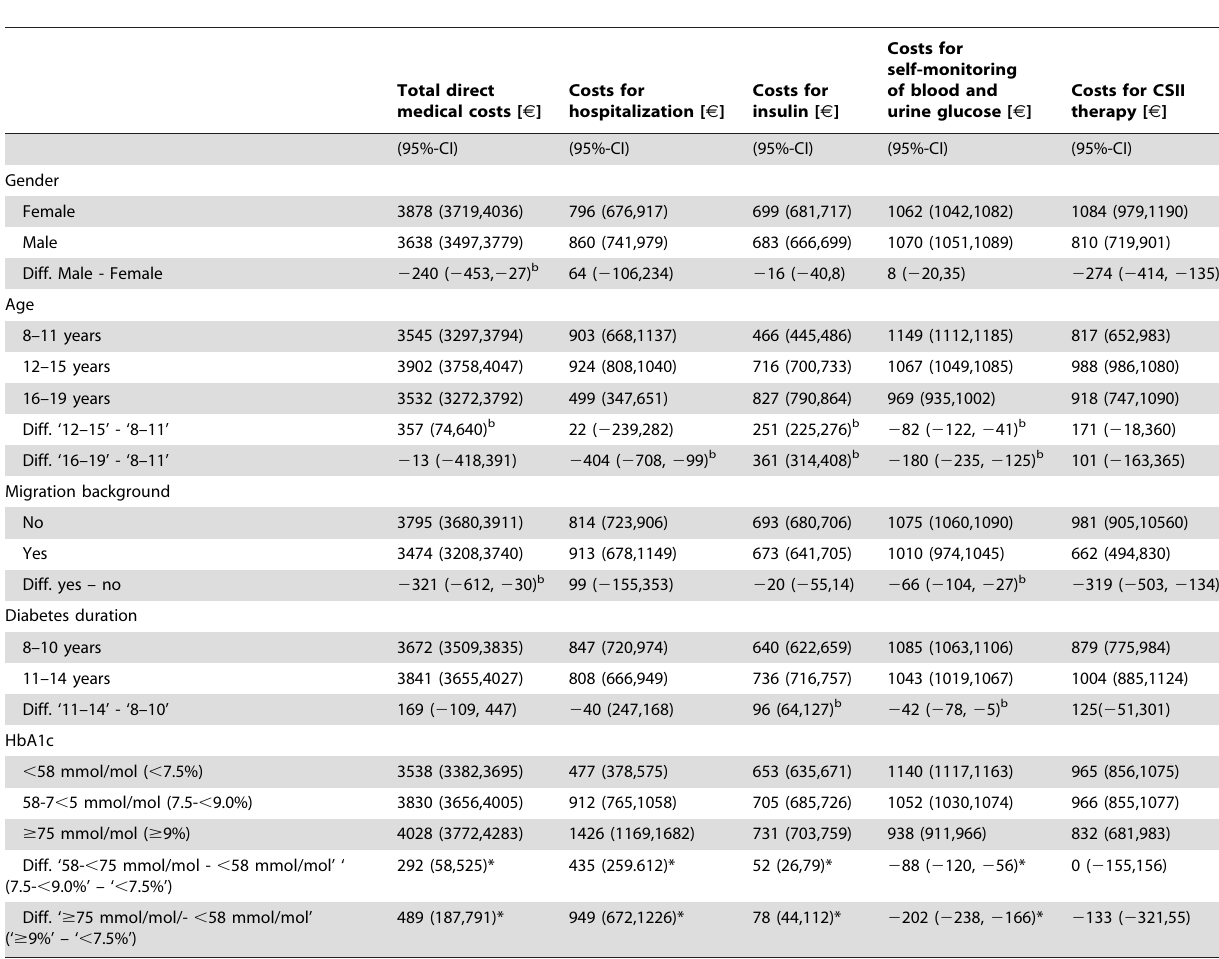
Table 6. Factors associated with total direct medical costs and different cost categories per patient: Estimates of cost and cost differences a